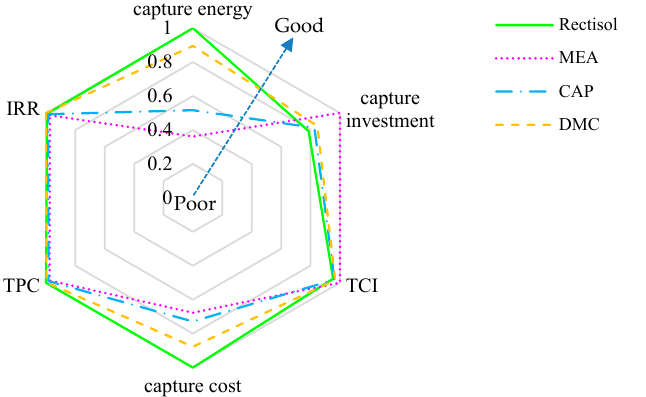
Figure 12. Comprehensive performance of CTEG process with different CO 2 capture technologies.